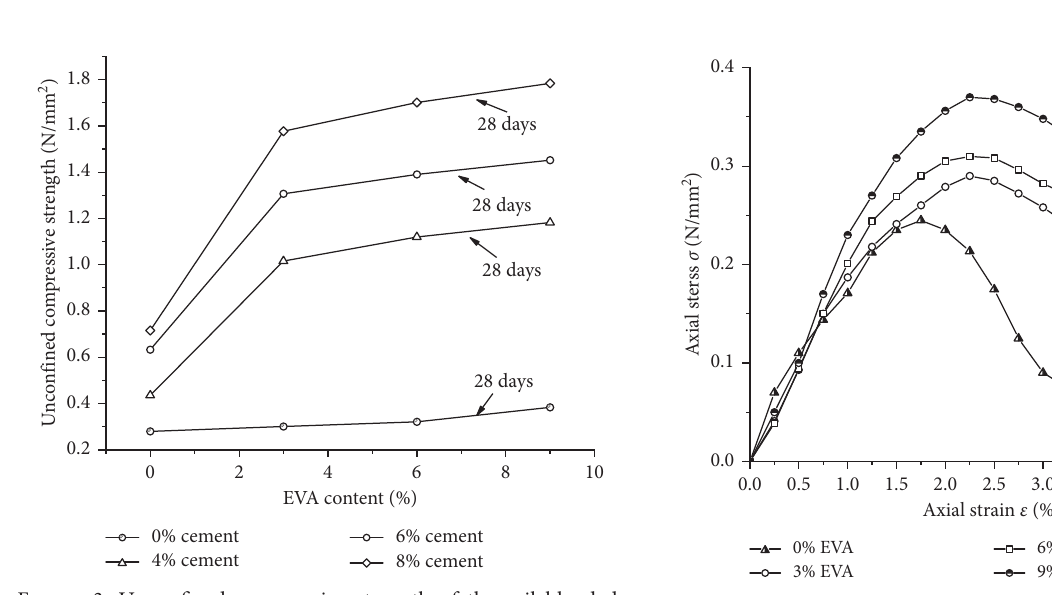
Figure 2: Correlation of shear strength parameters with soil at various fractions of cement and EVA: (a) Cohesion; (b) Angle of friction.